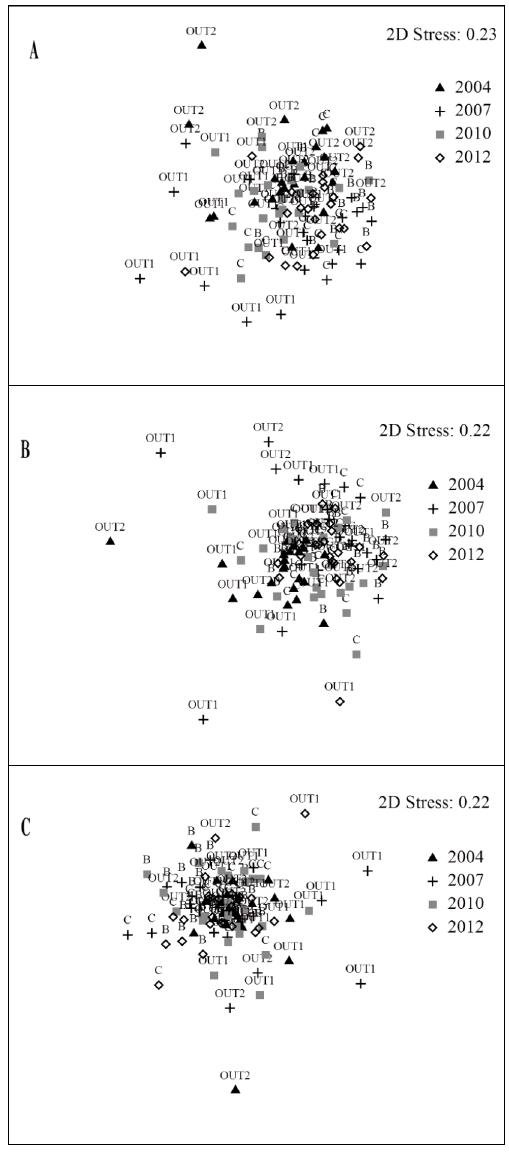
biomass of commercial